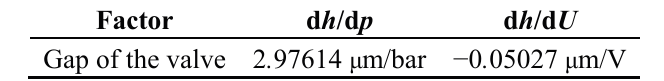
Table 3. Factors of the parametric fit function of the simulation results for the gap of the